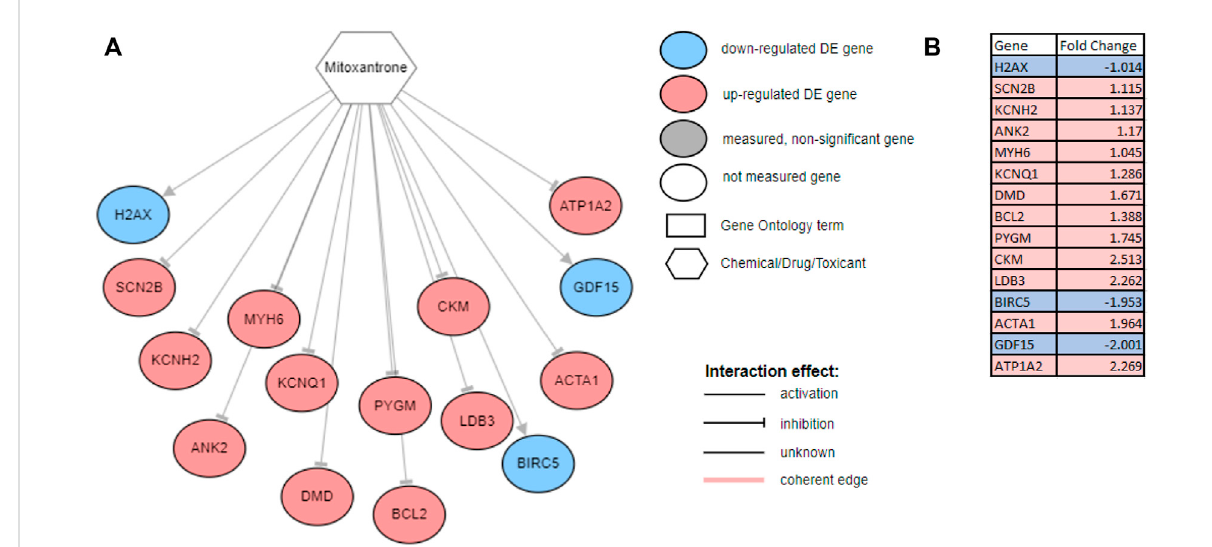
FIGURE 5 (A) The mechanism through which Mitoxantone act on the genes measured to be DE for prostate cancer. Note that, out of the 19 downstream DEgenesthatMitoxantoneisinteractingwith,15wereconsistentwiththehypothesis,i.e.,thedrugwasabletoreverttheexpressionchangescaused by disease 15 out of 19 times. All 15 genes were shown on the fi gure with three down-regulated genes (blue circles) being activated, and 12 up- regulated genes (red circles) being inhibited with the exposure of the drug. (B) Fold changes reported for cell lines treated with Mitoxantrone. The upregulated genes are highlighted in red, and the downregulated genes are highlighted in